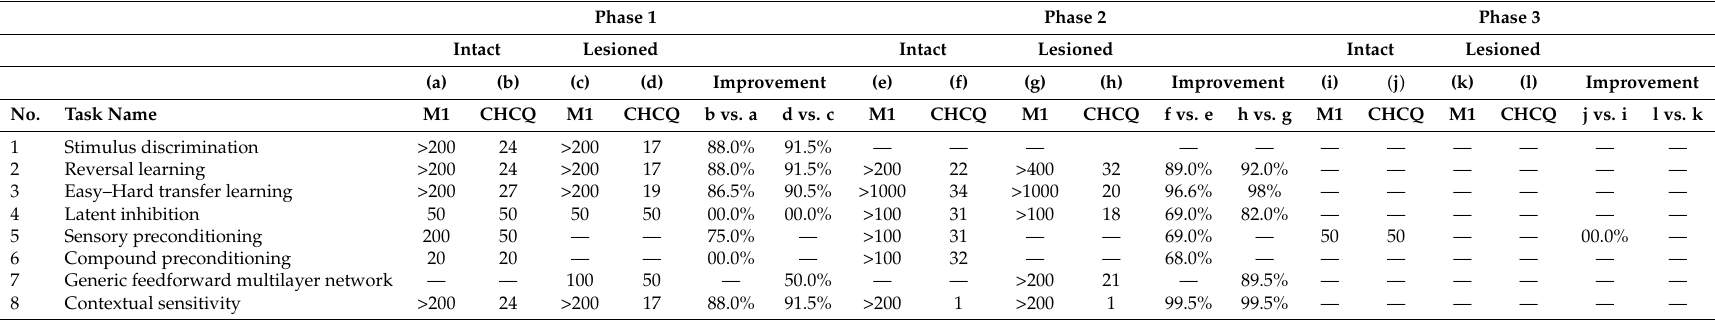
Table 2. A comparison between M1 (Gluck/Myers model) and the CHCQ model, in terms of trial numbers needed to get the final state of conditioned response (CR).